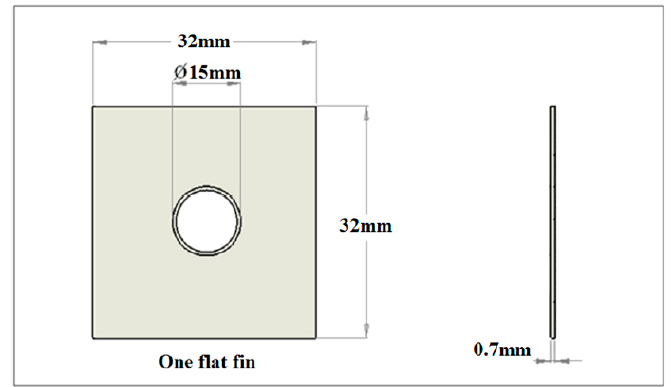
Figure 16. Drawing dimensions for Aluminium flat finned heat exchanger used to generate volume and surface area of fin.